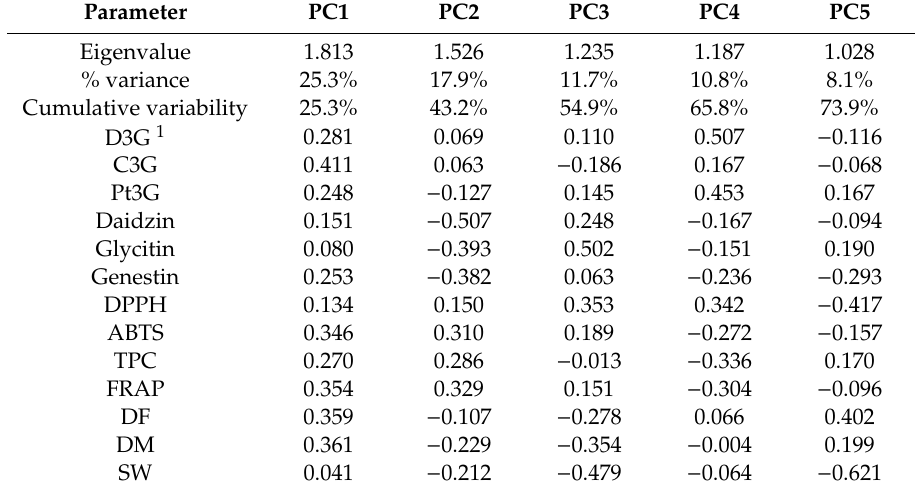
Table 4. Principal component analysis of the phytochemicals and antioxidant activities of 172 Korea black soybean landraces, eigenvalues, and percentage variability explained by the first five components.